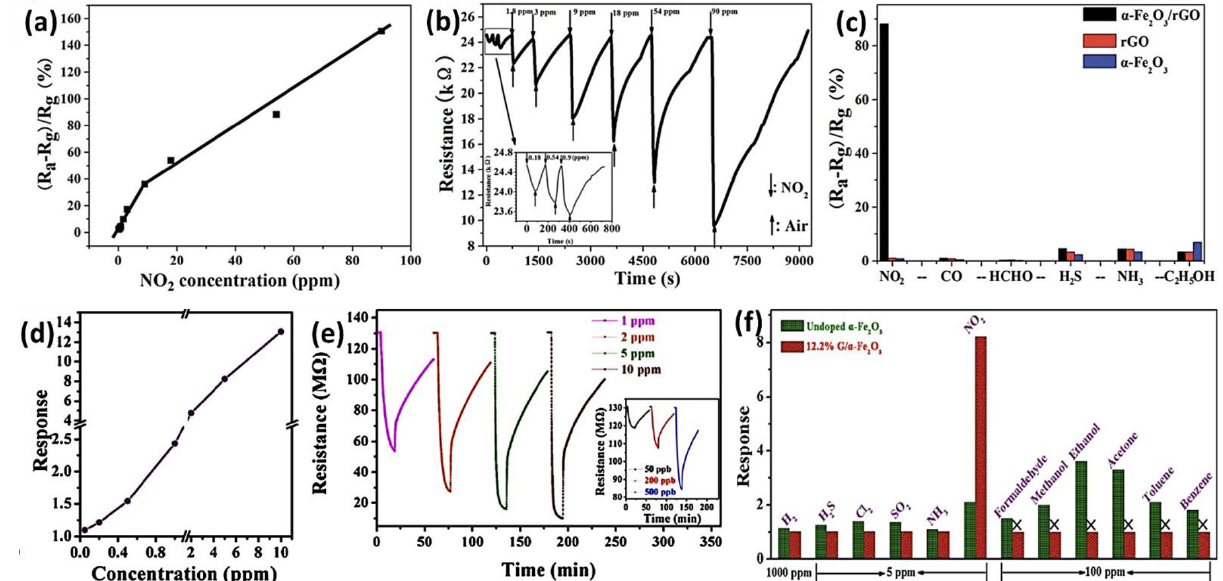
Figure 5. ( a ) The response of α -Fe 2 O 3 /rGO nanocomposite as a function of NO 2 concentration at RT, ( b ) dynamic responses of α -Fe 2 O 3 /rGO nanocomposite towards different NO 2 concentrations, and ( c ) selectivity of α -Fe 2 O 3 /rGO nanocomposite, rGO, and α -Fe 2 O 3 to different gases at RT. Adapted with permission.106 ( d ) The response of 12.2% α -Fe 2 O 3 /rGO as a function of NO 2 concentration at RT, ( e ) dynamic response of 12.2% α -Fe 2 O 3 /rGO at different NO 2 concentrations, and ( f ) selectivity of 12.2% α -Fe 2 O 3 /rGO and α -Fe 2 O 3 towards various gases. Adapted with